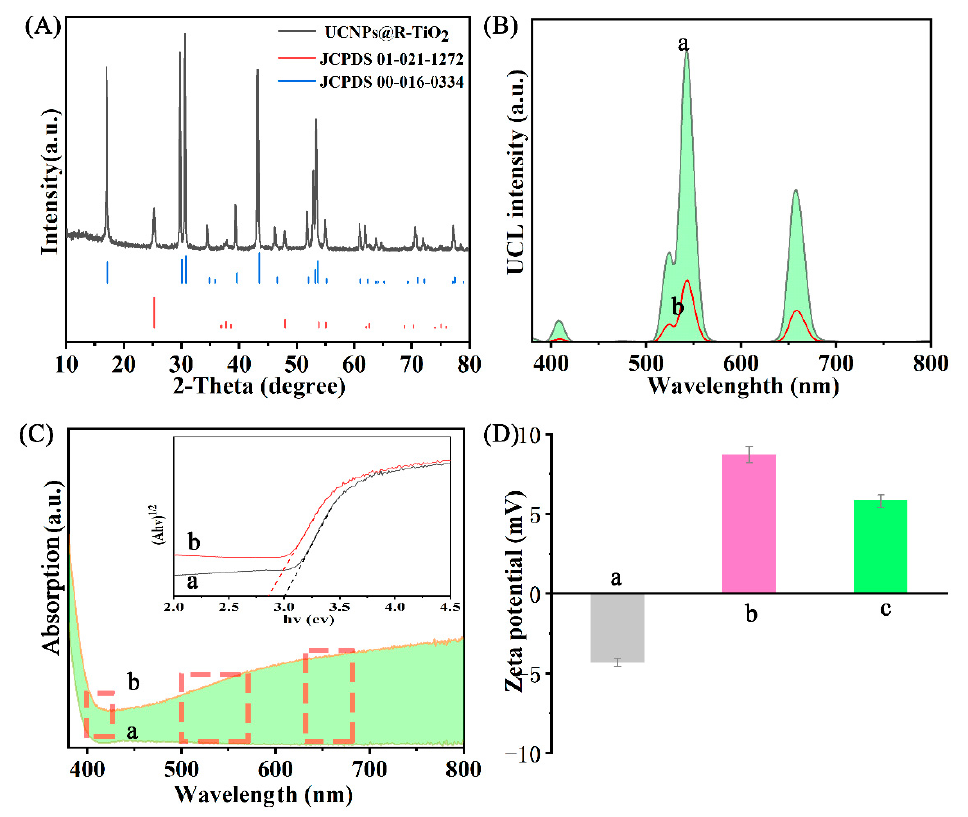
Figure 3. ( A ) X-ray powder diffraction (XRD) patterns of UCNPs@R-TiO 2 and the standard hexag- onal phase (JCPDS 00-016-0334) and anatase phase (JCPDS 01-021-1272). ( B ) The upconversion luminescence (UCL) spectrum of the UCNPs (a) and UCNPs@R-TiO 2 (b). ( C ) The UV-Vis absorp- tion spectrum of TiO 2 (a) and R-TiO 2 (b), with insert showing the corresponding bandgap deter- mined by Tauc plot. ( D ) The zeta potential of UCNPs (a), R-TiO 2 (b), and UCNPs@R-TiO 2